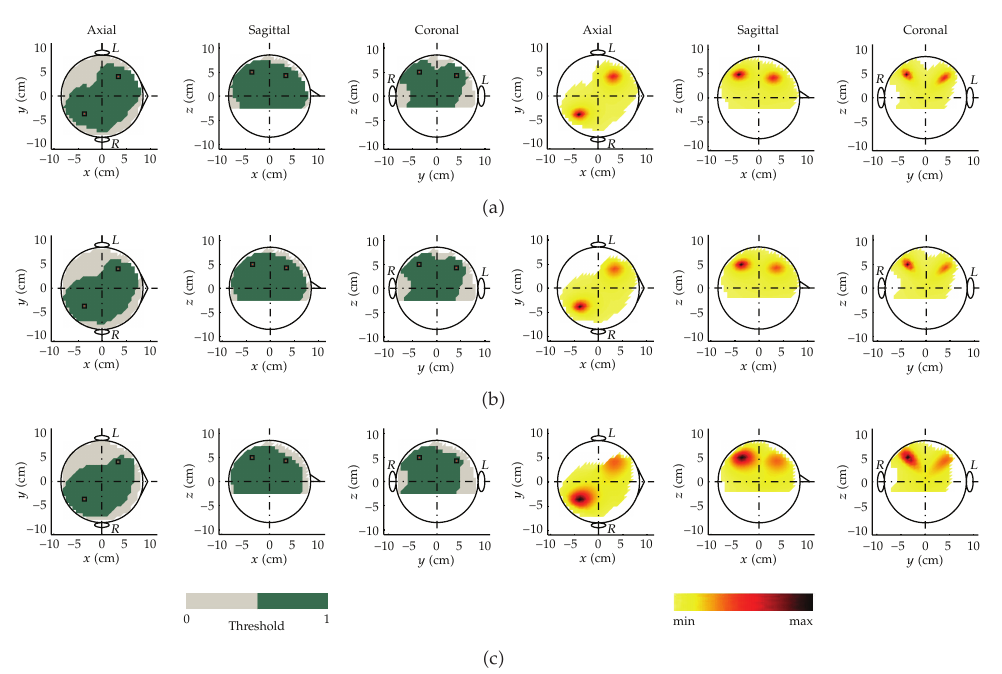
Figure 5: Reduced scanning regions (cid:2) left (cid:3) by our proposed strategy and reconstructed images (cid:2) right (cid:3) . All other configurations (cid:2) source locations, time courses, and SNR (cid:2)(cid:8) 1 (cid:3)(cid:3) are the same as in Figure 1. (cid:2) a (cid:3) Correlation: 0.1. (cid:2) b (cid:3) Correlation: 0.6. (cid:2) c (cid:3) Correlation: